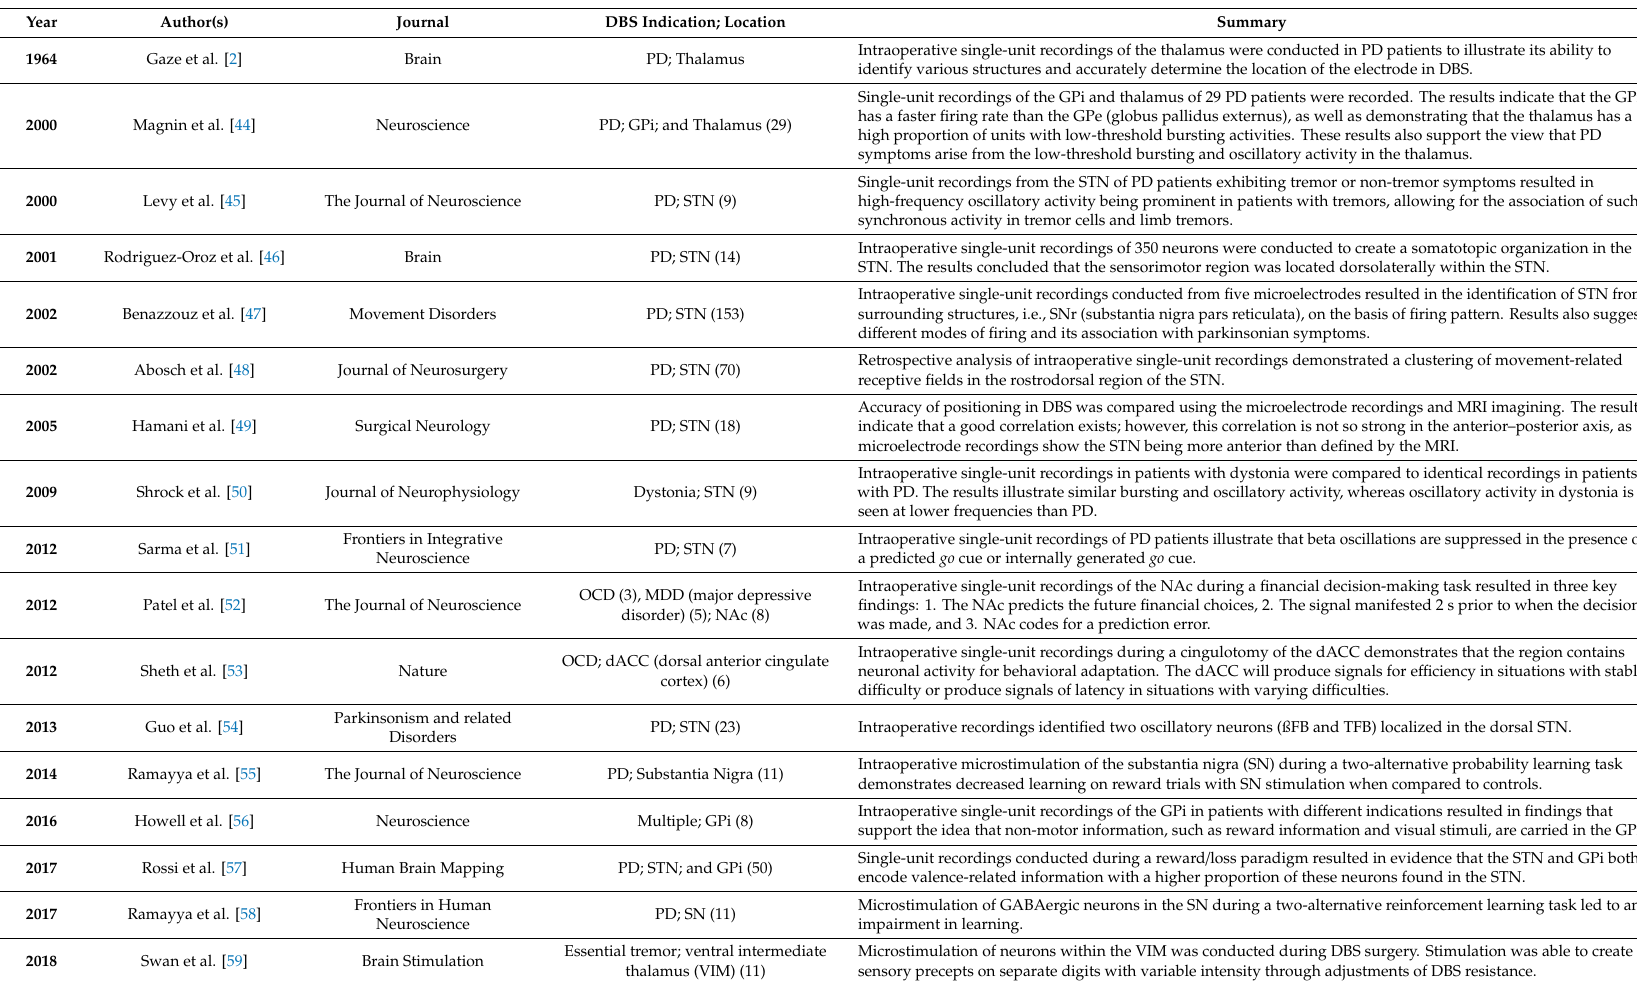
Table 3. Single Unit. OCD: obsessive-compulsive disorder, MRI: magnetic resonance